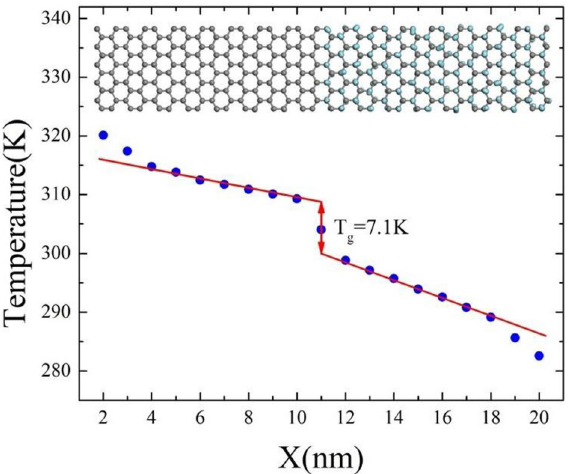
Figure 2. Steady-state: one-dimensional temperature profile for graphene/graphane hybrid nanoribbon with a length of 20.42 nm at T = 300 K and ΔT = 40 K.